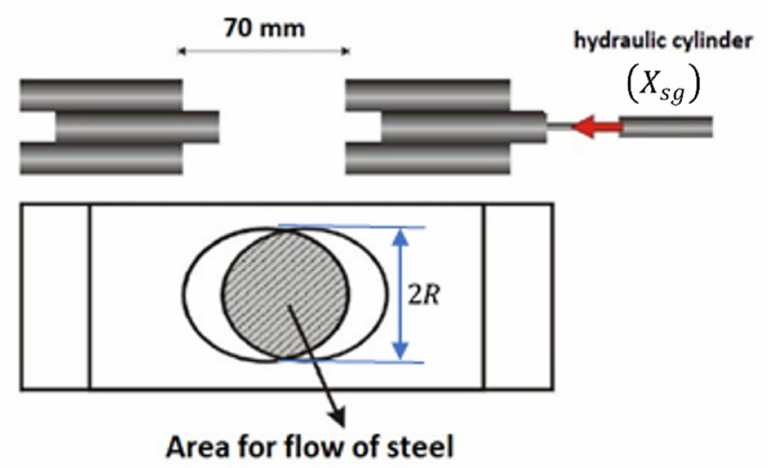
Figure 3. The shape of the slide gate